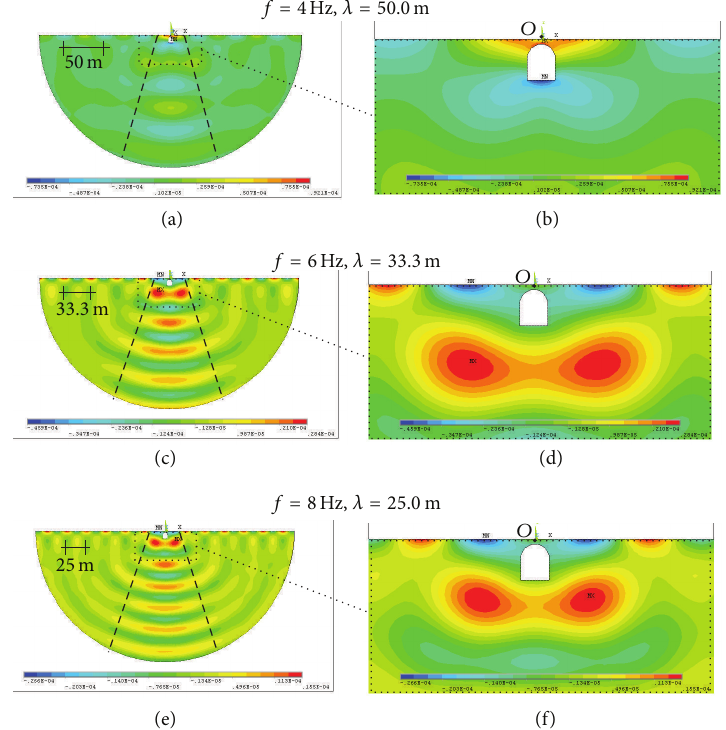
Figure 9: Real part of the horizontal scattered displacement, Re {̂𝑢 𝑠 1 } , for cave 3A at different values of the frequency 𝑓 .